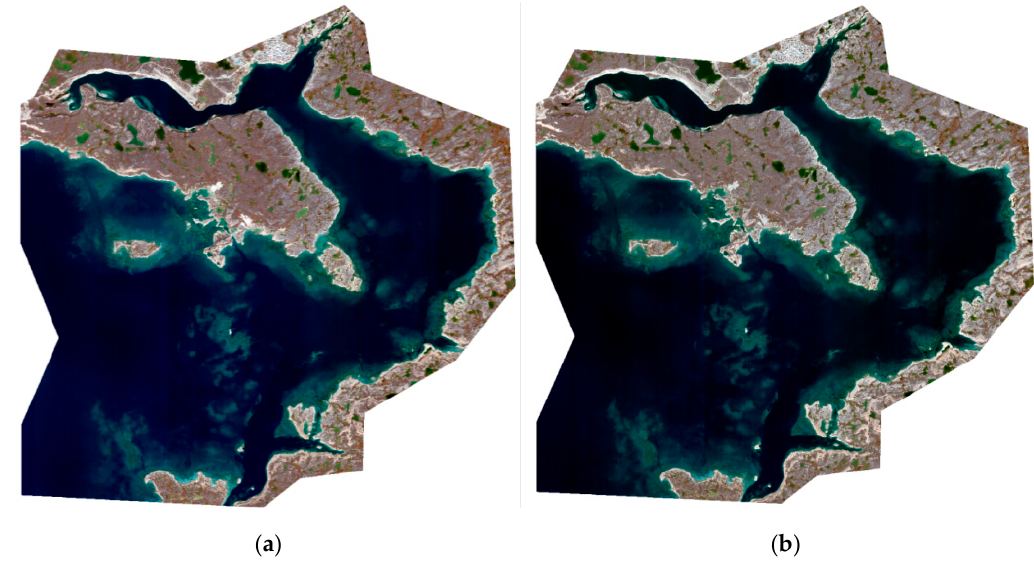
Figure 2. WorldView-2 stereo pair used for each Satellite Derived Bathymetry (SDB) technique. ( a ) Forward image, used for empirical and classification approaches. ( b ) Backward image, only used for photogrammetric techniques. Imagery © 2015, DigitalGlobe, Inc. Table 1. Image and stereo-pair geometry.